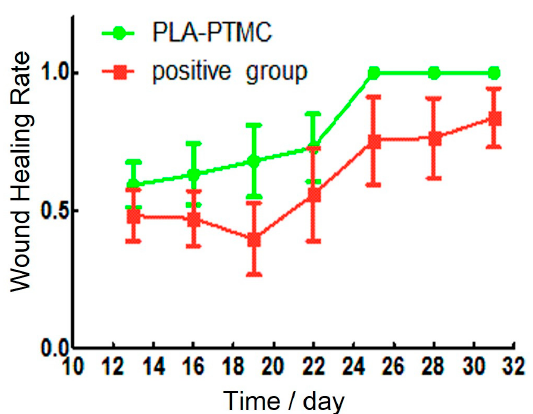
Figure 9. The wound healing rate of the PLA-PTMC group and the positive control group.